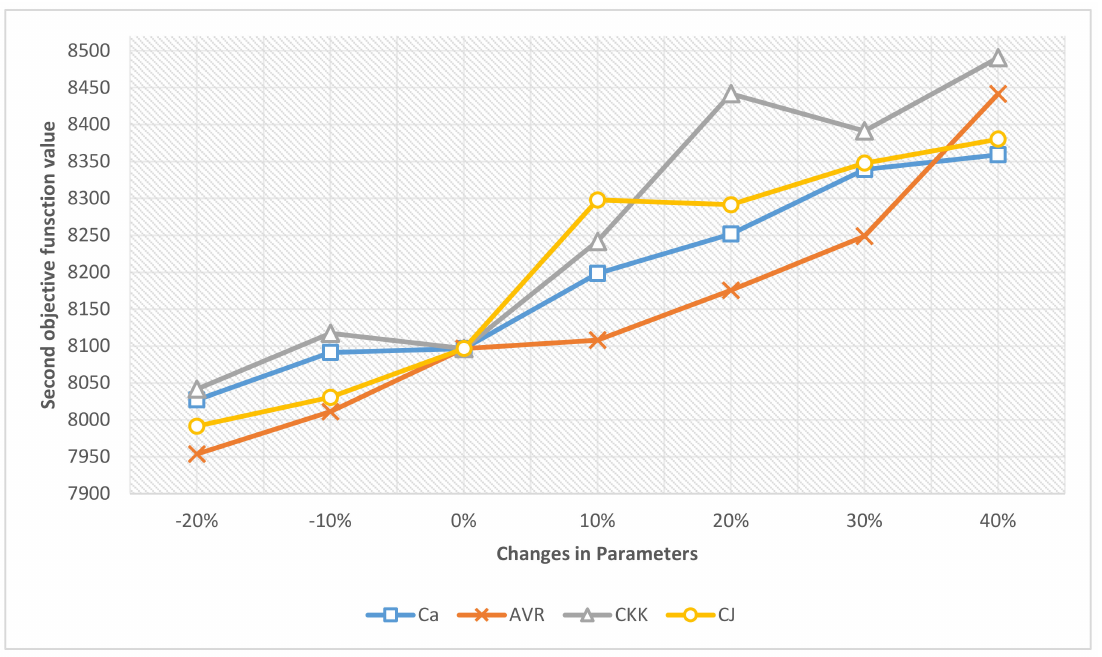
Figure 11. Sensitivity analysis of the second objective function by changing the important parameters.